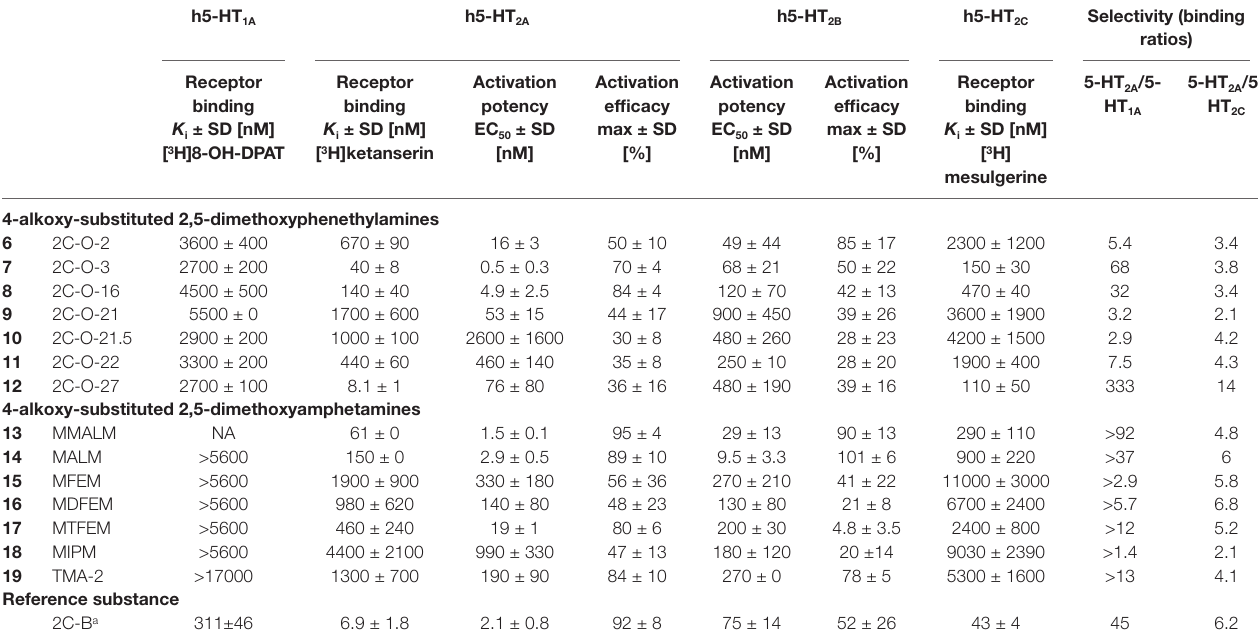
TABle 1 | Serotonin receptor binding affinities and activation potencies of 4-alkoxy-substituted 2,5-dimethoxyphenethylamines and